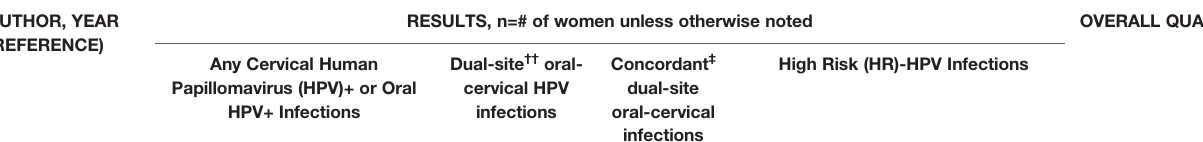
TABLE 3B | Results of the asynchronous oral-cervical HPV evaluation papers